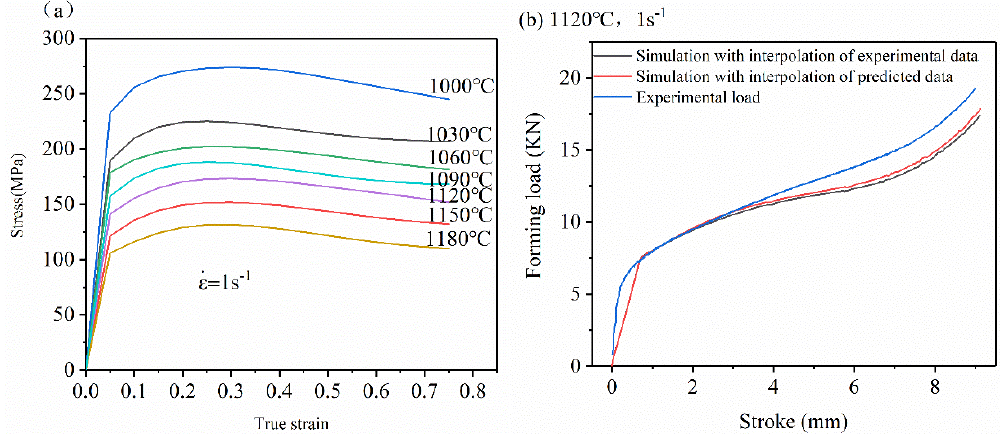
Figure 13. ( a ) ANN model prediction data ( b ) and different interpolation conditions by mold load comparison.